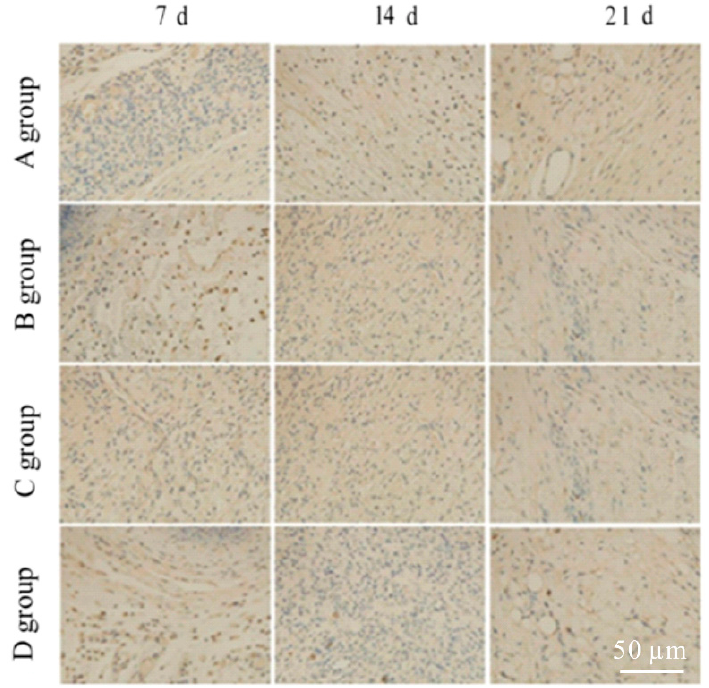
Figure 4. Expression results of bFGF at different time points. Notes: ( A ): model group; ( B ): dracorho- din perchlorate inflammation targeting emulsion gel group; ( C ): dracorhodin perchlorate non-tar- geting emulsion gel group; ( D ): positive group. Scale bar is 50 μ m.